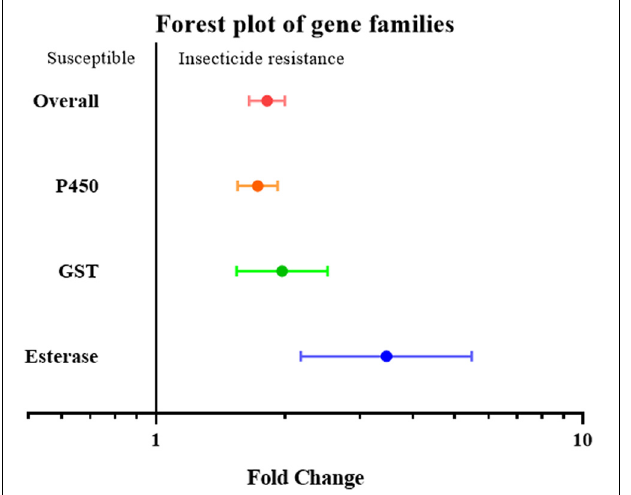
FIGURE 4 | Meta-analytical, sub-group estimate of the gene expression related to insecticide resistance, with 95% CI across different insecticide classes. The overall effect represents the collective effect of all the relevant